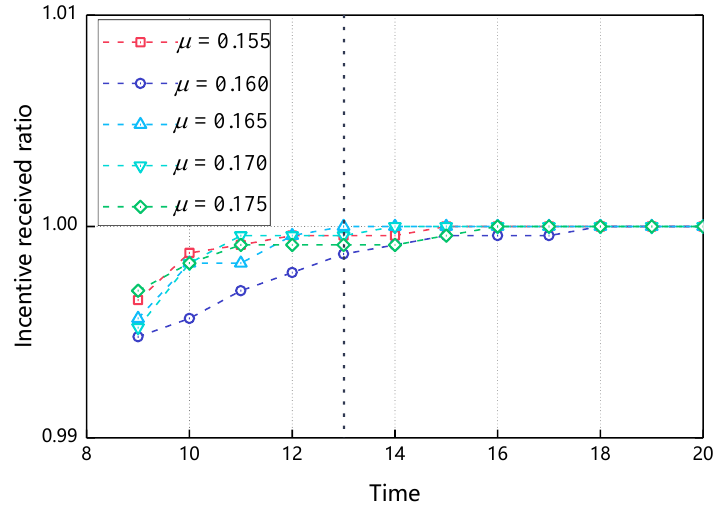
Figure 5. The impact of µ on incentive received ratio ( γ = 0.15, δ ∈ [ 0.1,0.9 ] , β ∈ ( 0,0.9 ) ).